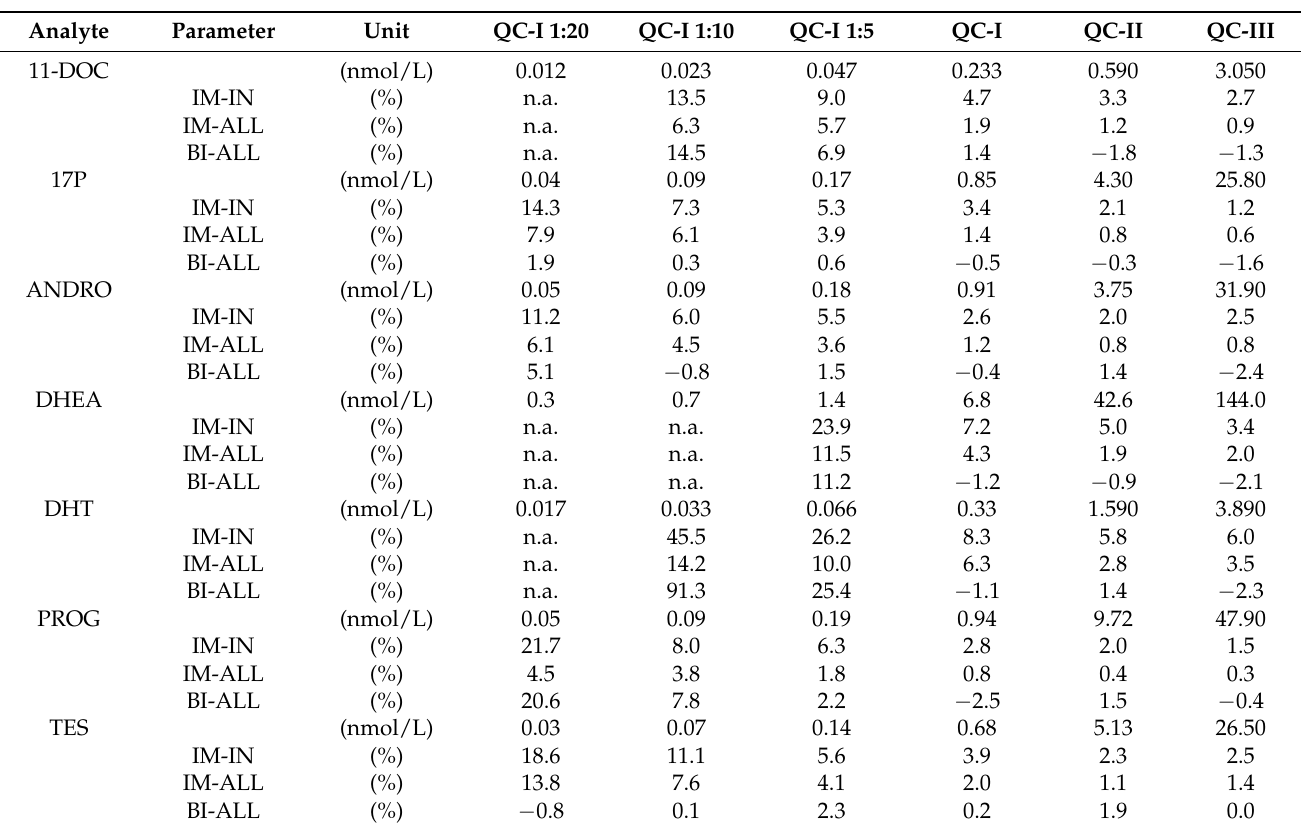
Table 1. Average intraday (IM-ALL) and total interday (IM-IN) imprecision and average interday bias (BI-ALL) calculated for every QC level of 11-deoxycorticosterone (11-DOC), 11-deoxycortisol (11-DF), 17-OH-progesterone (17P), 21-deoxycortisol (21-DF), androstenedione (ANDRO), aldos- terone (ALDO), corticosterone (CC), cortisol (CL), cortisone (CN), dehydroepiandrosterone (DHEA), dehydroepiandrosterone sulfate (DHEAS), dihydrotestosterone (DHT), estradiol (E2), progesterone (PROG), and testosterone (TES). QC-I 1:20, QC-I 1:10, and QC-I 1:5 are dilutions of QC-I and were included for confirmation of pre-estimated LLOQs. Number of samples: 9 times 5 for intraday imprecision, 45 for interday imprecision, and bias per QC level. Dilution levels below the predefined LLOQ were not analyzed (n.a.).